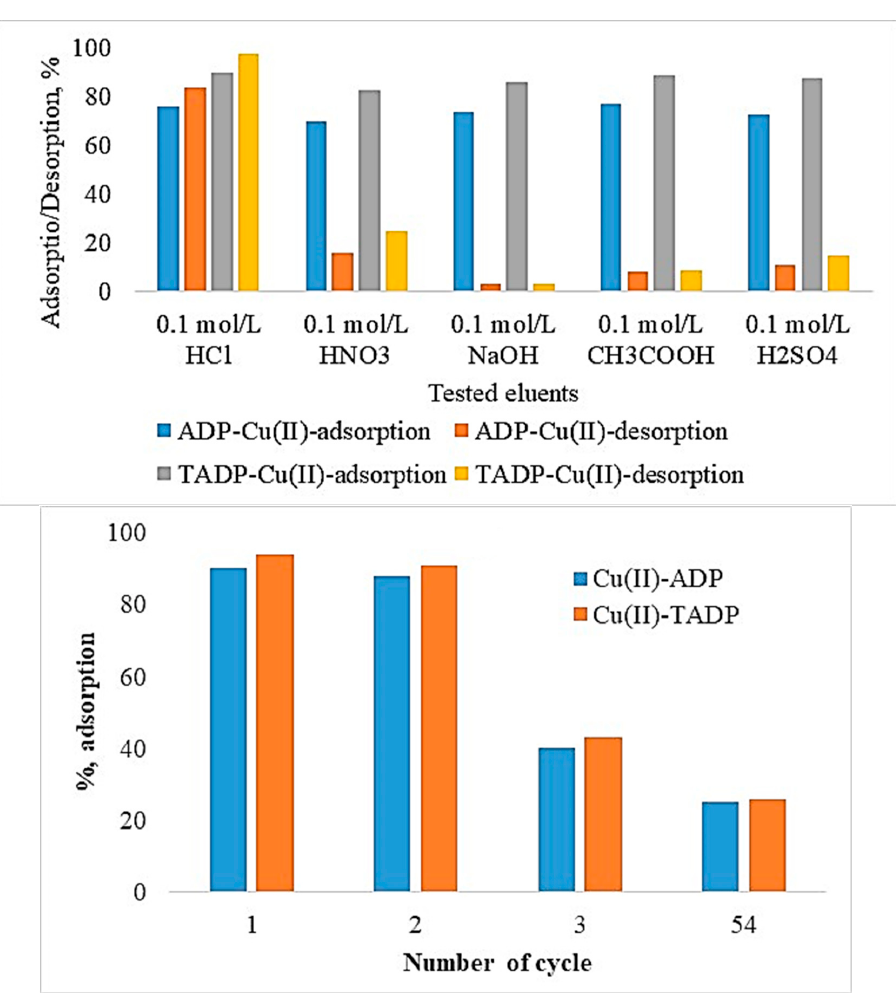
Figure 9. Cu(II) ion elution from saturated adsorbents (experimental conditions: Co: 25 mg/L; m: 0.05 g; V: 0.05 L; T: 25 °C; contact time: 5 h; agitation speed: 100 rpm).